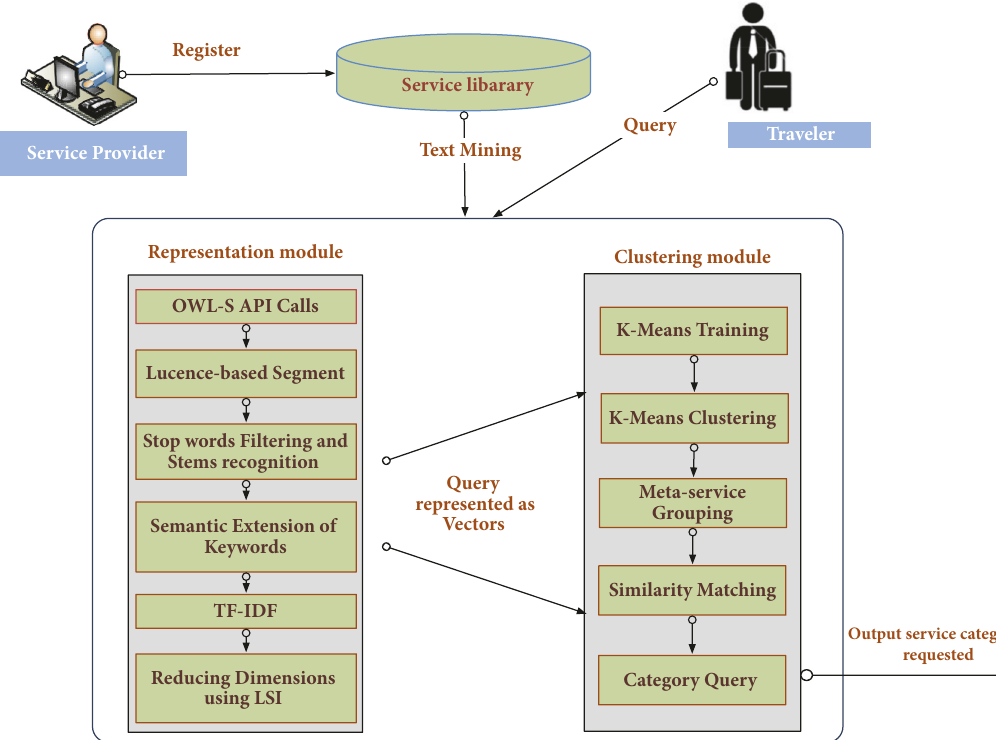
Figure 3: Illustration of service classification. Table 1: Some of the descriptions including the name and the keywords in the service library. Name of TIS